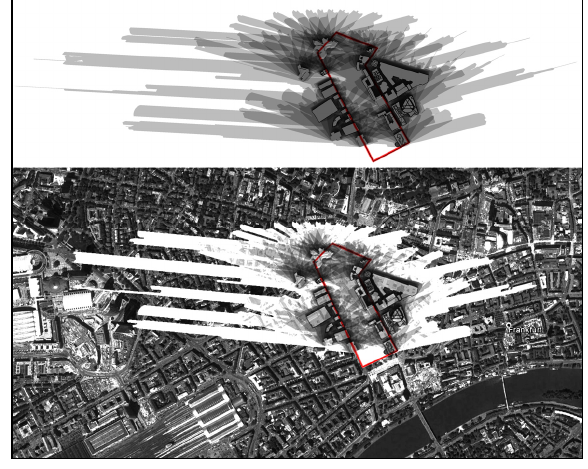
Figure 7. Frankfurt – shadow in main green public space by concentrated tall buildings (cityGML – LOD2), by: author